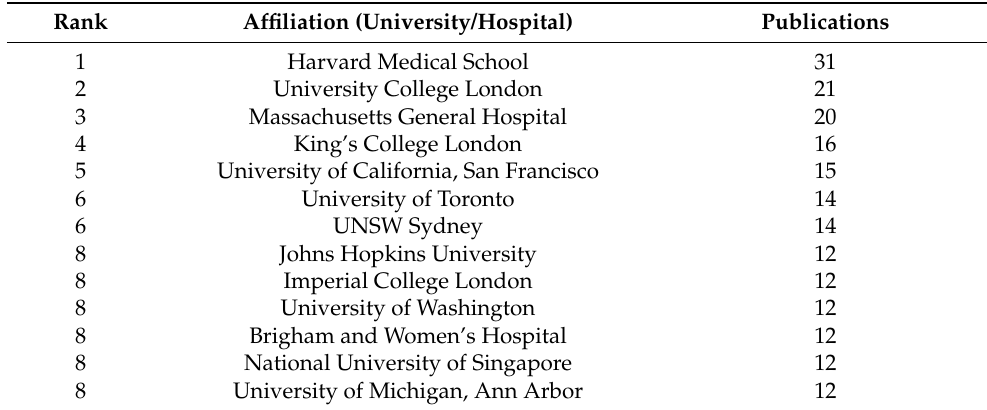
Table 1. Top universities/hospitals by the number of publications.